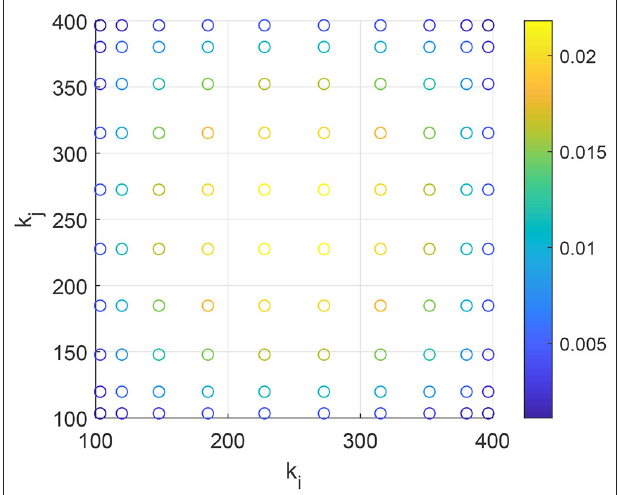
FIGURE 12 | Non-uniform 2D grid of degrees as explained in section 5.2.1 with m 100, M 400, s 10. The color shows the weight, w i w j , associated = = = with each point.